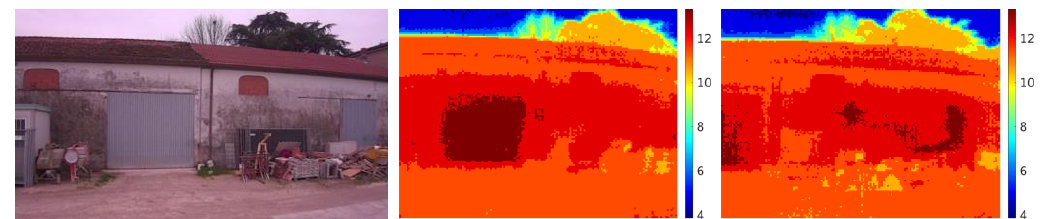
Figure 8. Images from the dataset. Picture of the building in the visible band (left) and same view captured in the thermal band (middle and right). The thermal range is between 3 and 14 °C.